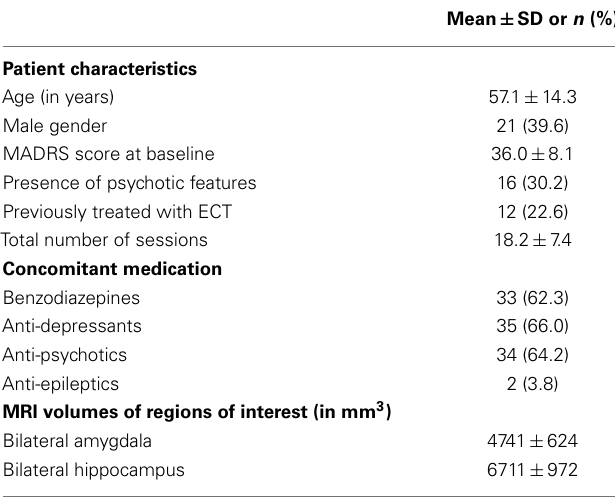
Table 1 | Patient and anatomical magnetic resonance imaging (MRI) descriptives at baseline of severely unipolar depressed patients ( n = 53) treated with electroconvulsive therapy (ECT)